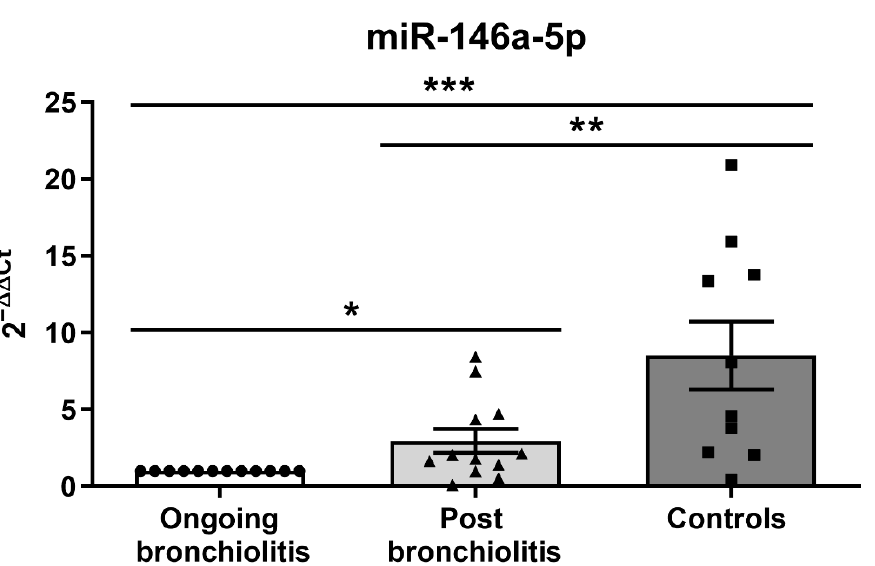
Figure 2. miR-146a-5p correlates with genes involved in immune responses. ( A ) Gene expression correlation (2 − ∆ Ct ) of miR-146a-5p and PTGS2 in NPA cells from infants with respiratory diseases. ( B ) Gene expression correlation (2 − ∆ Ct ) of miR-146a-5p and TSLP in NPA cells from infants with respiratory diseases. Lines indicate linear regression and dotted lines indicate 95% confidence bands of the best-fit line.